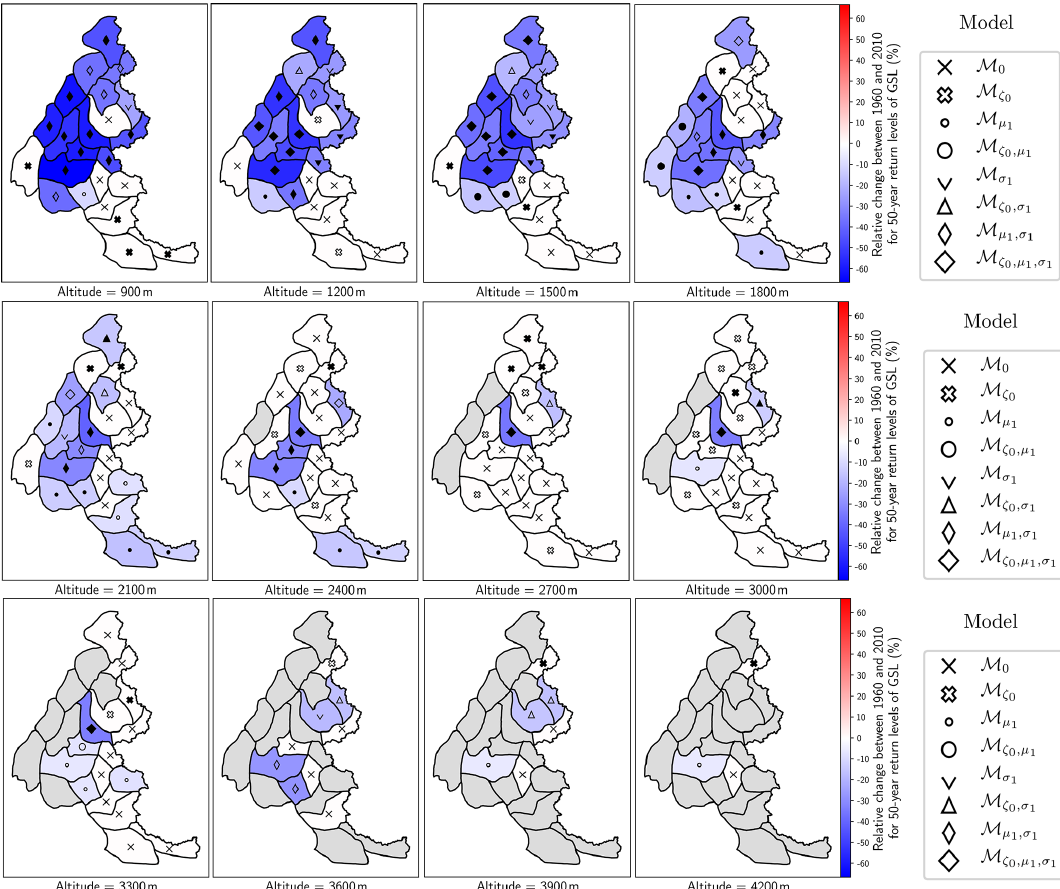
Figure A1. Trends in return levels of ground snow load (GSL) between 900 and 4200m of altitude. Markers show selected model M N , while filled markers symbolize models that are significantly better than the Gumbel model M 0 (Sect. 4.2). Grey areas denote either time series that were excluded (Sect. 4.4) or missing data, e.g. when the altitude considered is above the top altitude of the